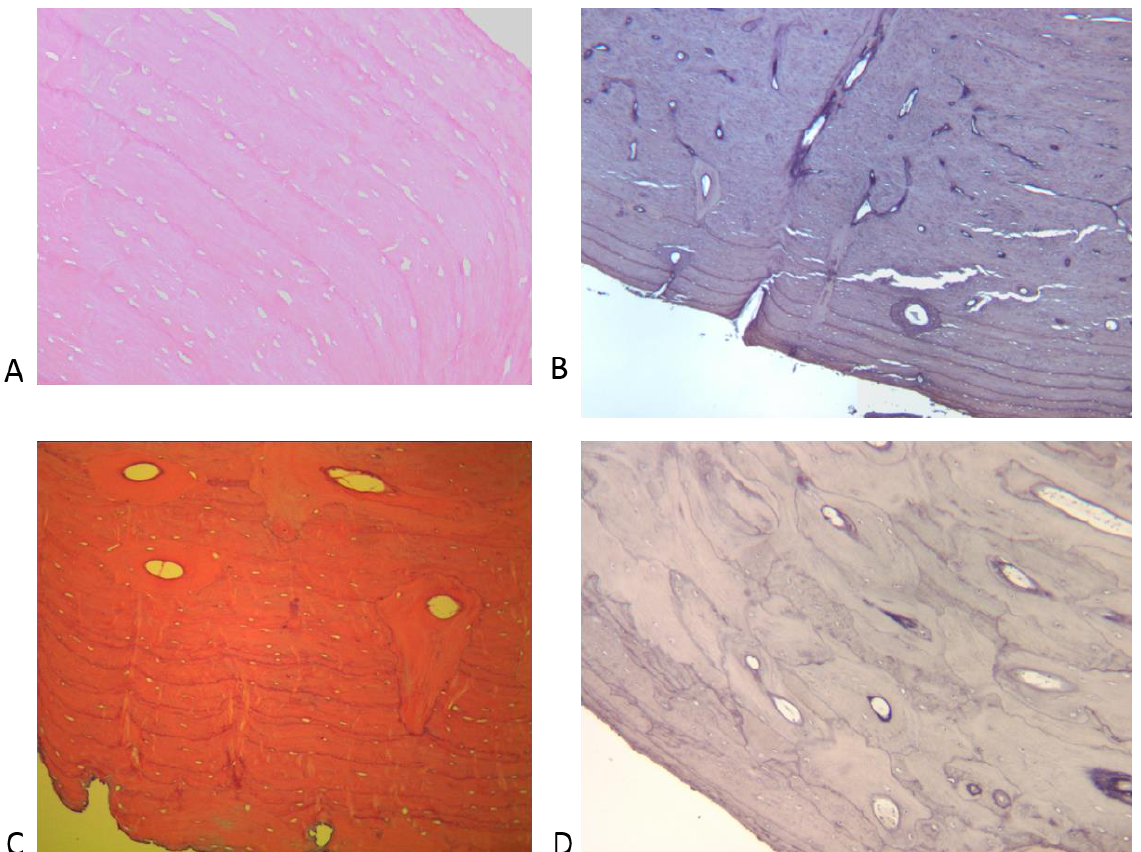
Fig. 4. Four levels of remodelling in manatee earbones are documented with each reading to help assess accuracy and precision of the reading. A) No remodelling (score 0) is represented (original magnification 40x) with GLG lines roughly parallel and showing no Haversian systems to interfere with reading. B) Light remodelling (score 1) has a low number of Haversian systems and widely scattered secondary osteons (photo original magnification 10x). C) Moderate remodelling (score 2) is the start of possible age-assigning difficulties and there are more sporadic small aggregations of Haversian systems (photo original magnification 10x). D) In heavy remodelling (score 3), the Haversian systems are abundant and make the GLGs very hard to read (photo original magnification